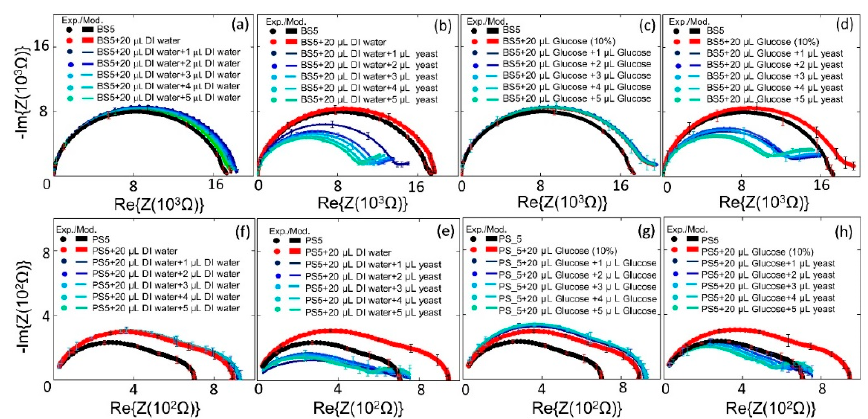
Figure 5. Experimental and modeled Nyquist plots of the Biochip BS5 with no filling and with DI water (20 µL) and ( a ) with additional DI water with volume from 1 µL to 5 µL, and ( b ) with additional S. cerevisiae volume from 1 µL to 5 µL. ( c ) no filling and with 10% glucose (20 µL) and with additional 10% glucose with volume from 1 µL to 5 µL, and ( d ) with additional S. cerevisiae volume from 1 µL to 5 µL. ( f ) biochip PS5 with no filling and with DI water (20 µL) and ( a ) with additional DI water with volume from 1 µL to 5 µL, and ( e ) with additional S. cerevisiae volume from 1 µL to 5 µL. ( g ) no filling and with 10% glucose (20 µL) and with additional 10% glucose with volume from 1–5 µL, and ( h ) with additional S. cerevisiae volume from 1–5 µL.